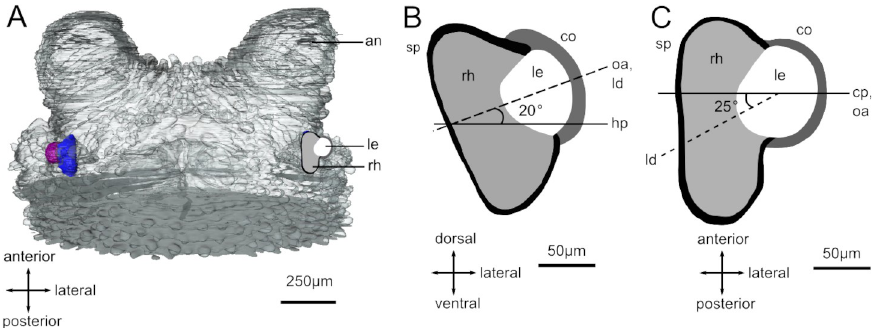
Fig 3. Reconstructed head and eye of the E.rowelli. (A) Orientation of the eyes in the head of the worm (reconstruction from sections of a single head, adopted from [9]. (B,C) The eye at higher magnification in vertical and horizontal planes. The elongated part of the retina extends to the rear in the head. Abbreviations: Cornea (co), lens (le), rhabdom layer (rh), screening pigment layer (sp), horizontal plane (hp), coronal plane (cp), antennae (an), Optical aperture (oa), lens direction